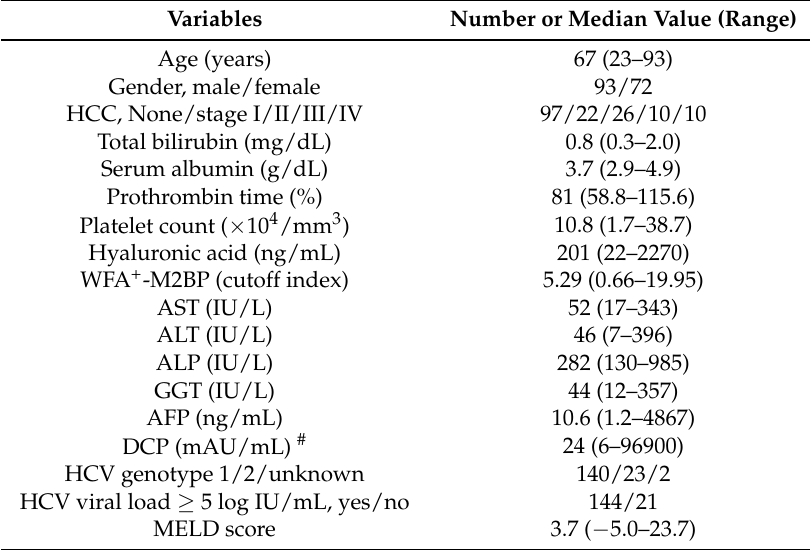
Table 1. Baseline characteristics ( n = 165).